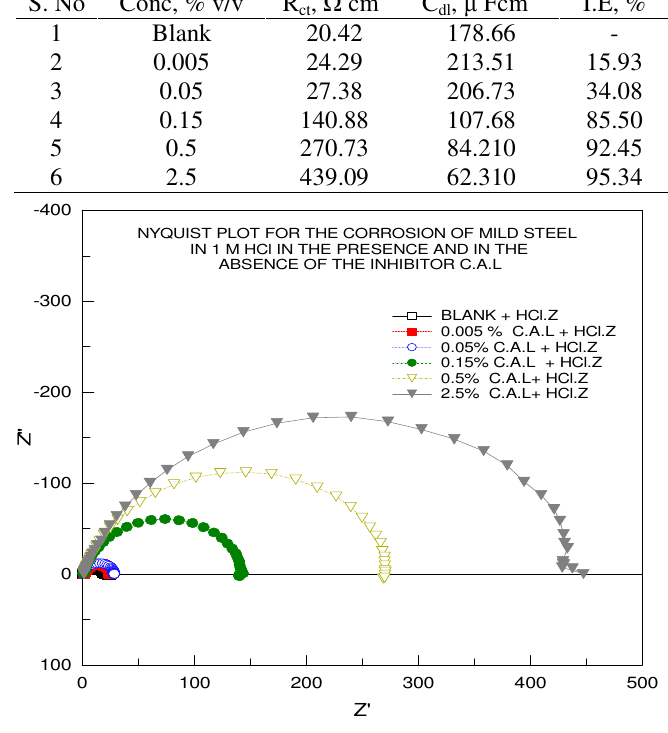
Figure 8. Nyquist